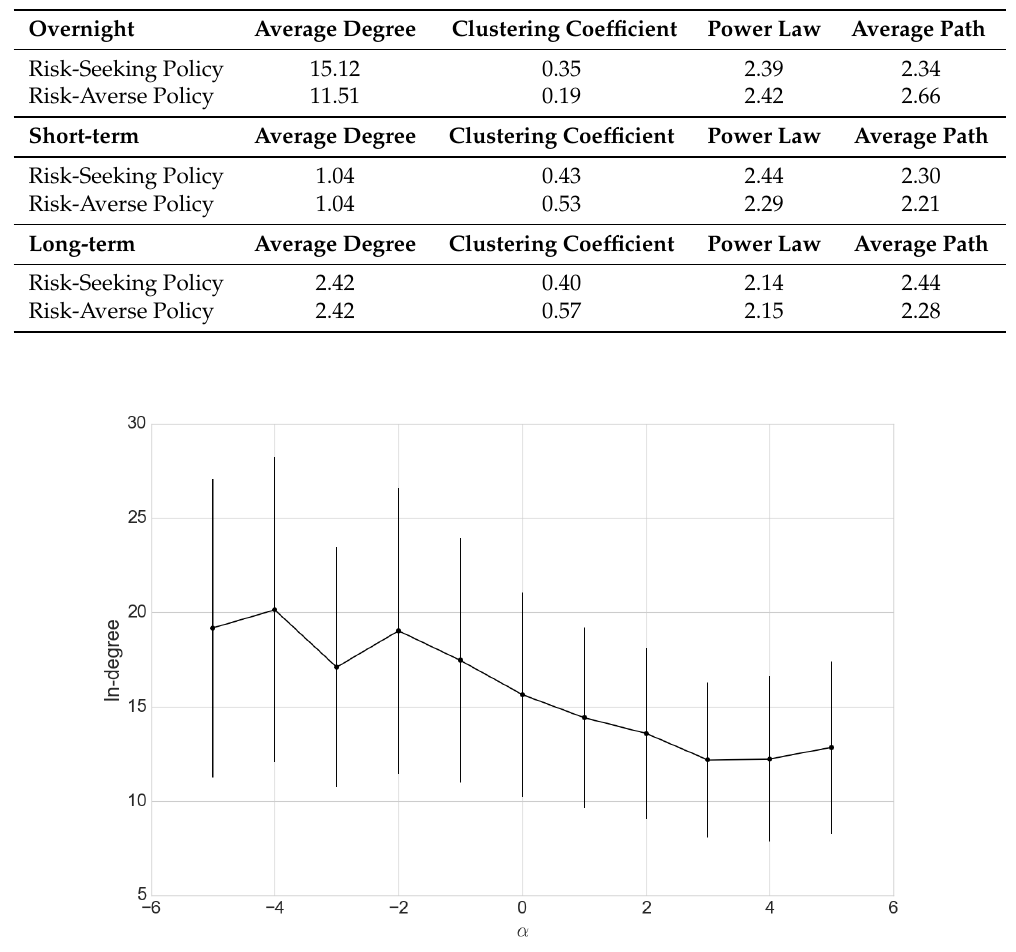
Table 7. Interbank network properties.